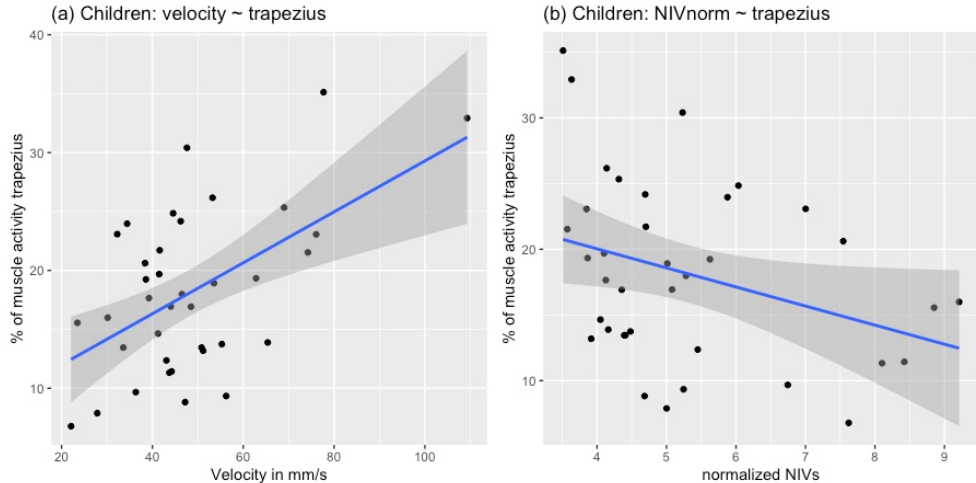
Figure 7. Regression lines with confidence intervals for linear regression models of writing velocity